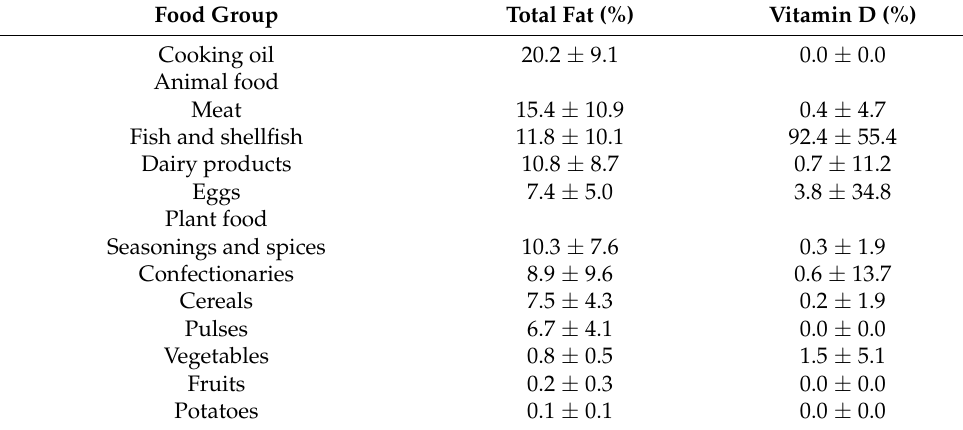
Table 3. Contribution of each food group to total fat and vitamin D estimated by a brief-type diet history questionnaire in adult subjects of the Hirado–Takushima